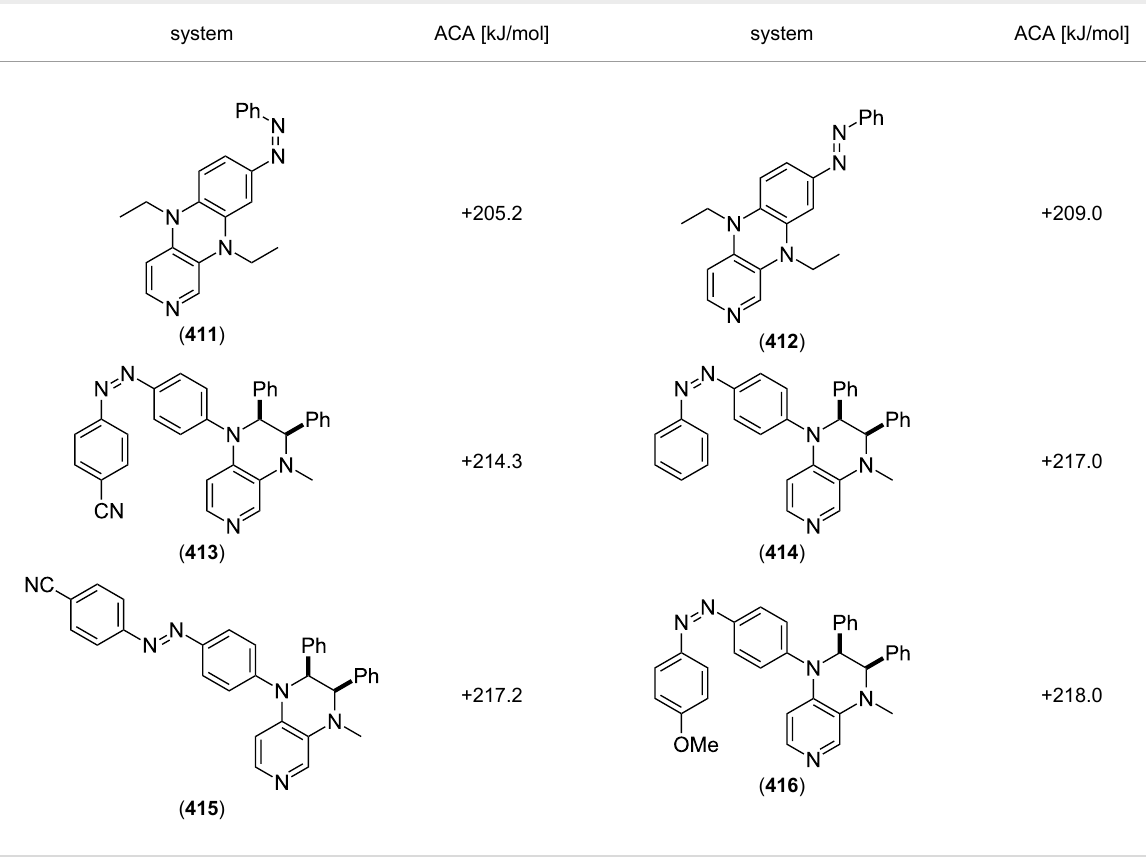
Table 15: ACA values of 3,4-diaminopyridines with diazo moiety, ordered by increasing ACA